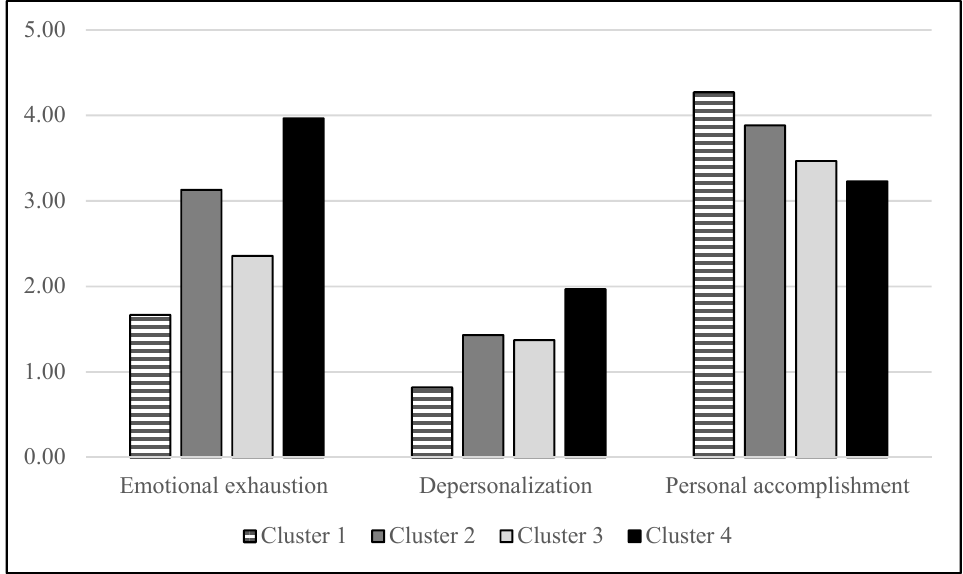
Figure 2. Burnout differences by clusters.